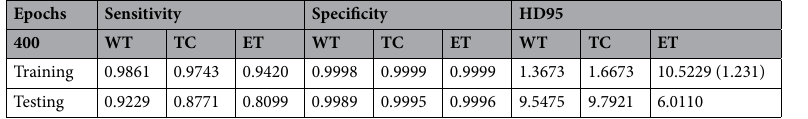
Epochs Sensitivity